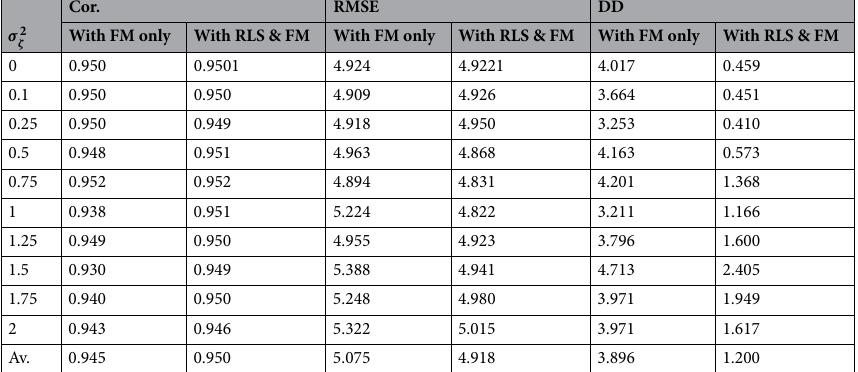
Table 7. RMSE, Correlation (Cor.) and Depth Distortion (DD) in % for shape reconstruction using FM:GRA3 with different levels of variance of Jitter noise ( σ 2 ξ = ( 2 ak + b ) 2 σ 2 ζ + 2 a 2 σ 4 ζ ), with and without proposed RLS filter.